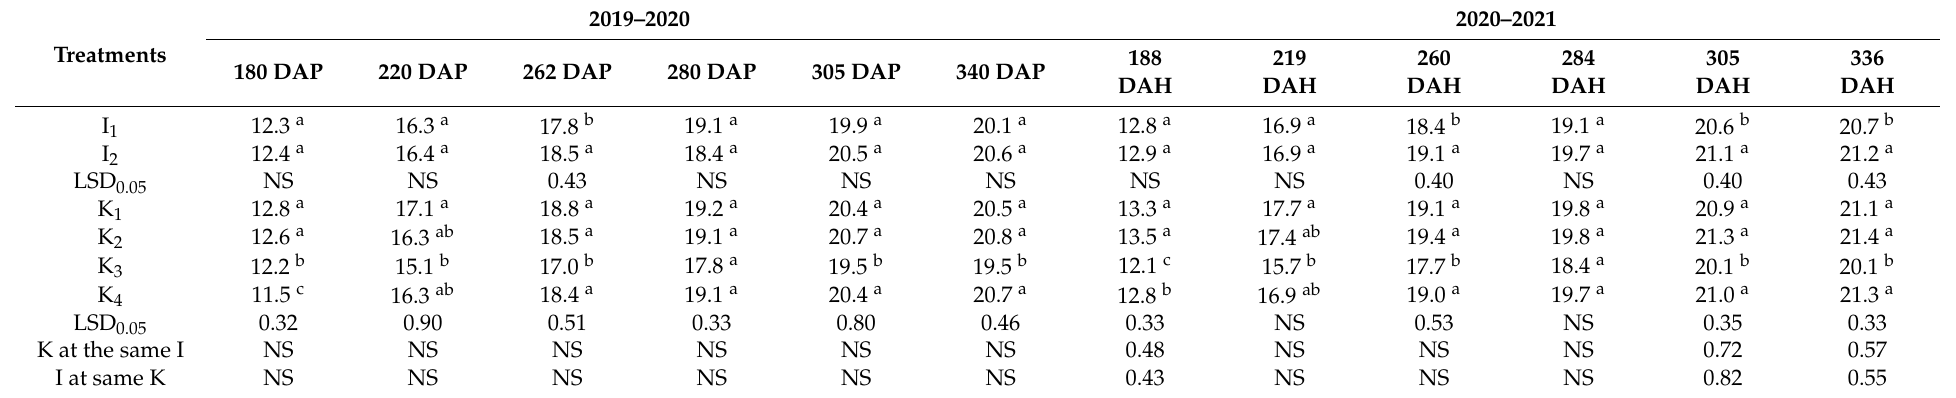
Table 7. Nodes per cane as a function of irrigation and potash